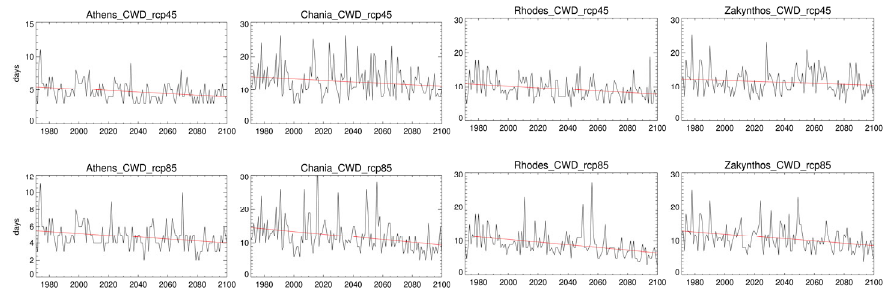
Figure 7. Consecutive wet days (CWD) during 1971–2100 in four Greek stations based on RCP4.5 (top row) and RCP8.5 (bottom row).